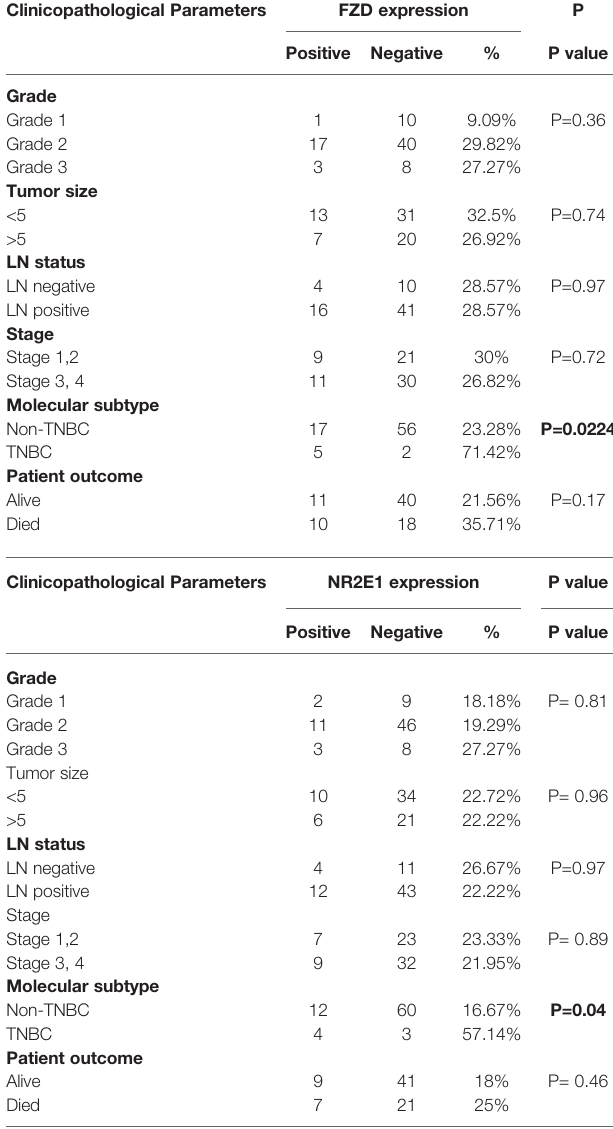
TABLE 1 | The association between FZD9 and NR2E1 immunoreactivity in different clinicopathological parameters in our patient cohort that consists of 80 breast cancer